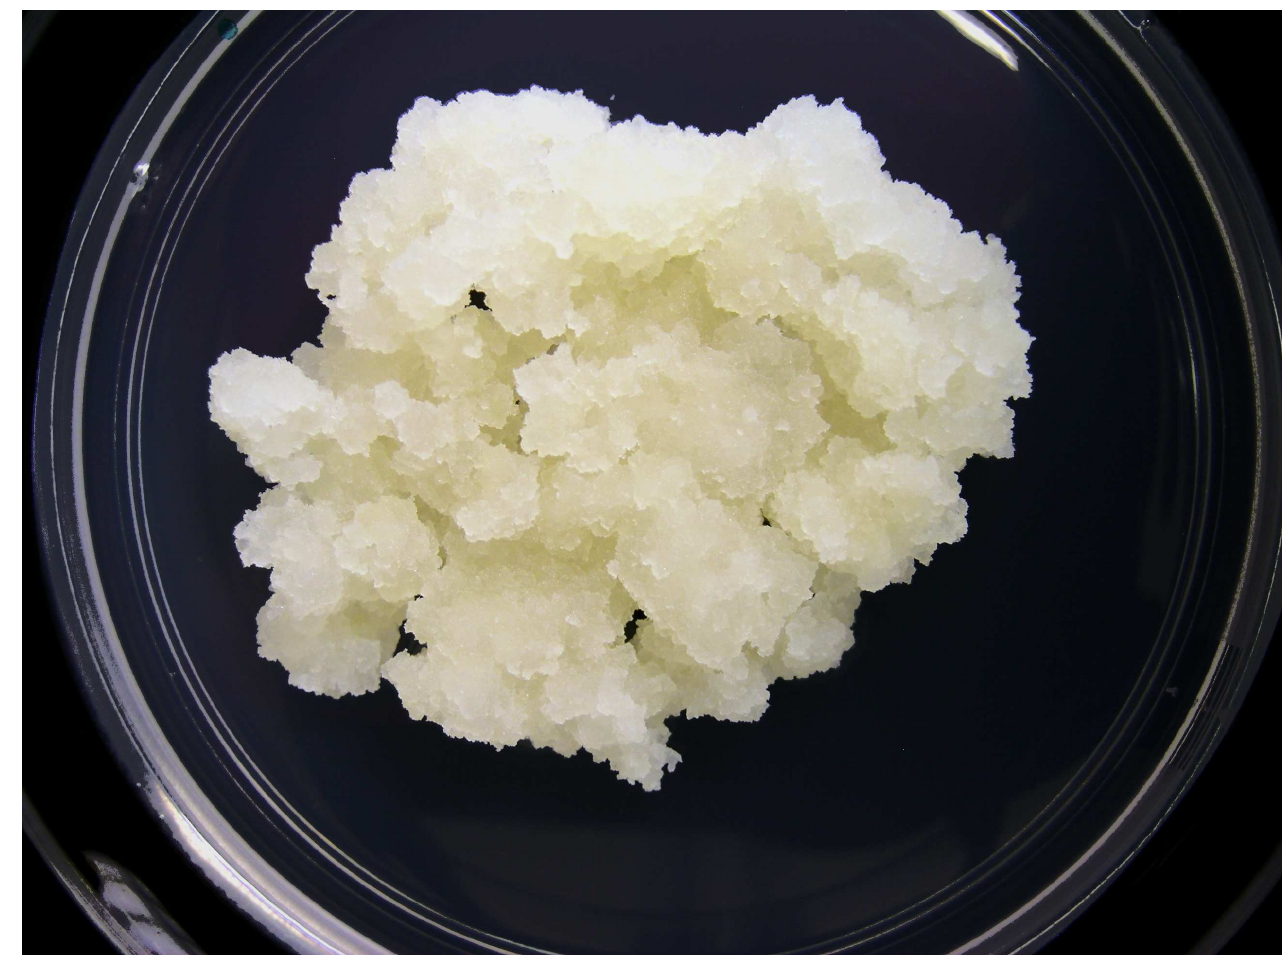
Fig 1. Nonembryogenic citrus cell line of Valencia sweet